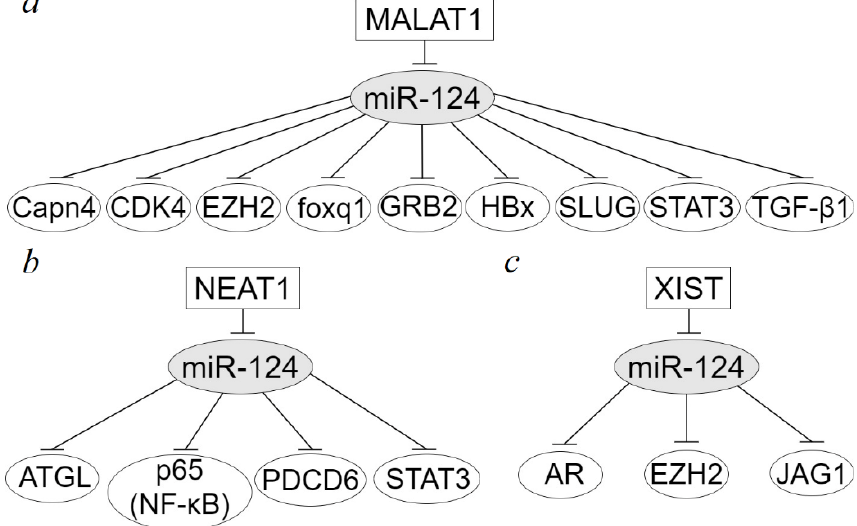
Figure 2. MiR ‐ 124 interactomes with the most abundant lncRNAs such as MALAT1 ( a ), NEAT1 ( b ), and XIST ( c ) in epithelial cancer. and XIST ( c ) in epithelial